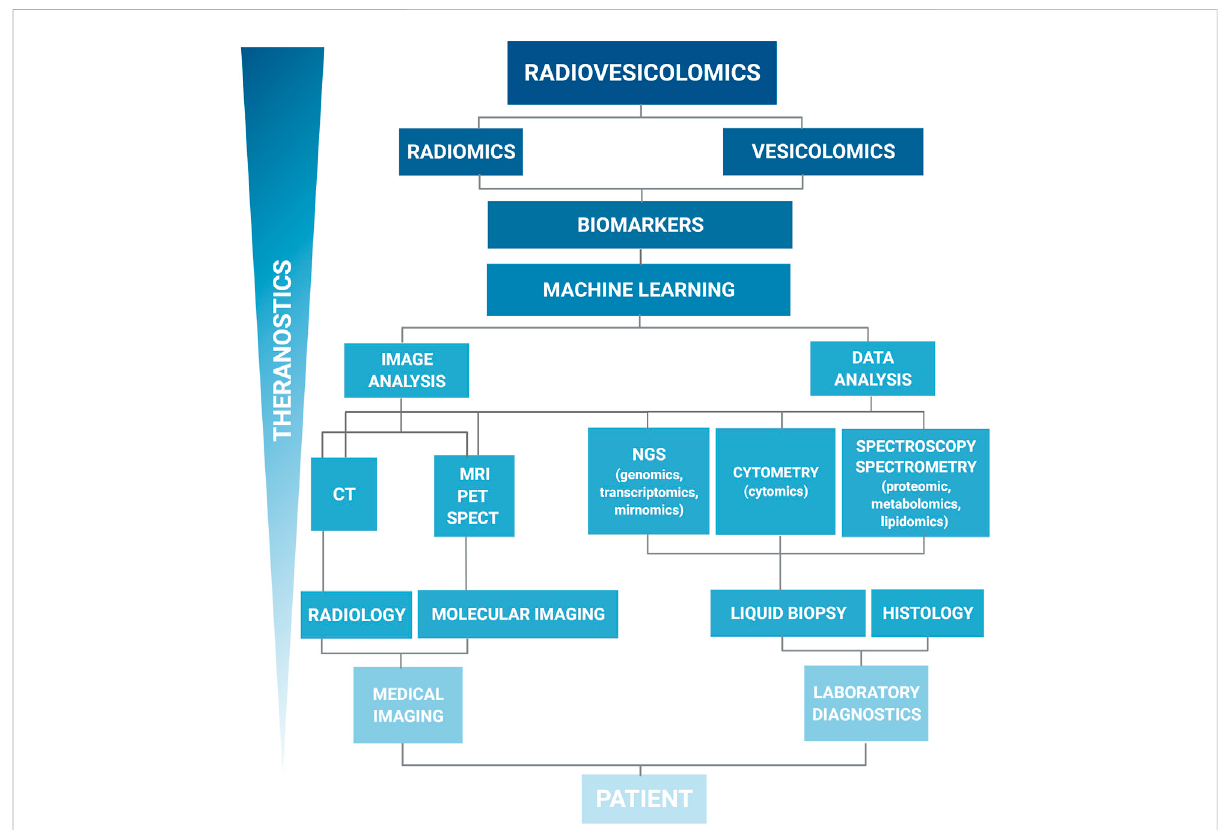
FIGURE 1 Hierarchical organization of the data work fl ow for the systemic data collection and analysis. The left branch represents imaging data, the right branch represents the omic data. Such organization of the data collection systems is showing the integration and synergy of imaging and laboratory diagnostics for newbiomarkersdiscovery.Liquid biopsy, includingextracellular vesiclesamples, isanalternative for traditionalhistology. Onthetop, radiomics and vesicolomic are coupled to form radiovesicolomics as the new approach in medical imaging and